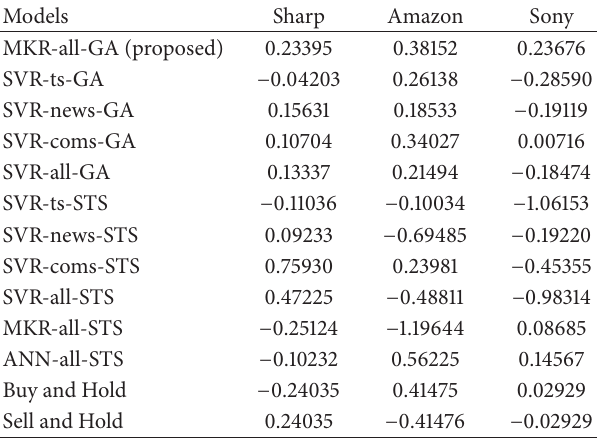
Table14:Sharperatiosinthefivetestingdatasetsforthethree-stock